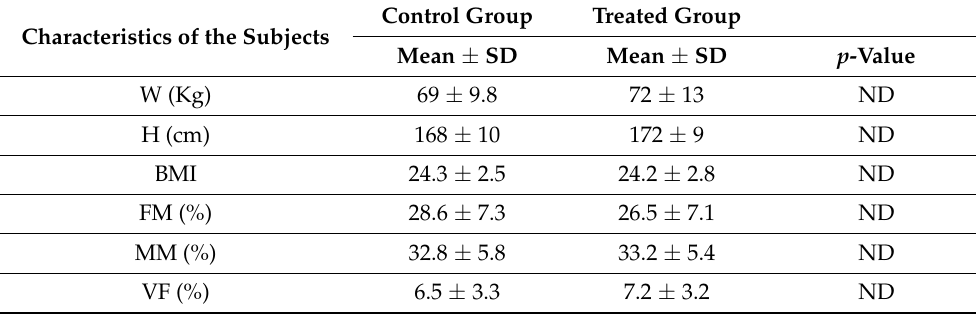
Table 2. Characteristics of the subjects in the two groups of study. W = weight, H = height, BMI = body mass index, FM = fat mass, MM = muscle mass, VF = visceral fat; ND = not statistically different from each other. Values are means ± SD. n = 12 in each